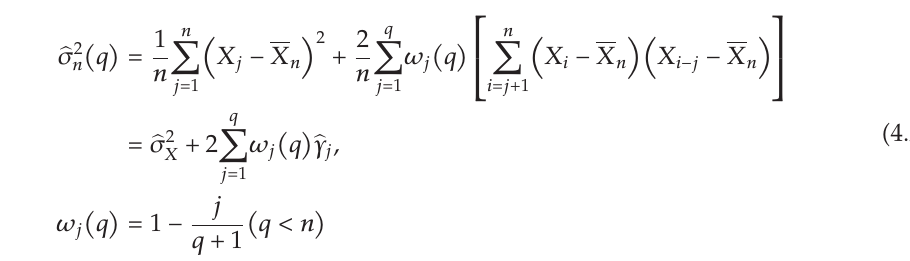
(cid:12) σ 2 (cid:12) γ j denote the sample variance and the autocovariance estimators of X and